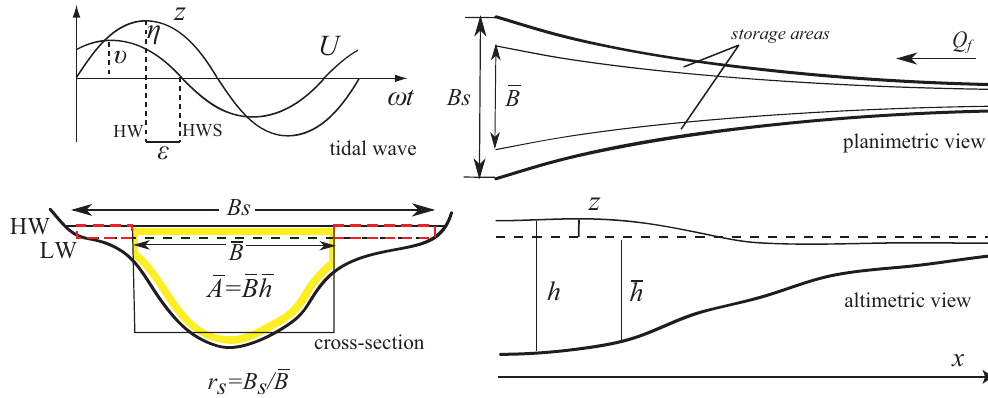
Fig. 1. Sketch of the estuary geometry and basic notations (after Savenije et al.,